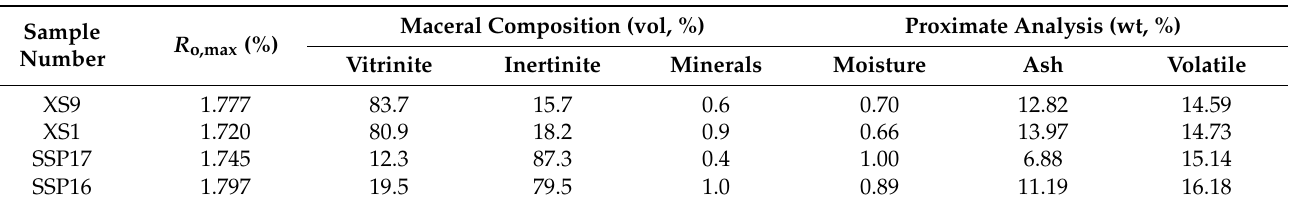
Table 1. Information of coal samples including R o,max , maceral composition, and proximate analysis.